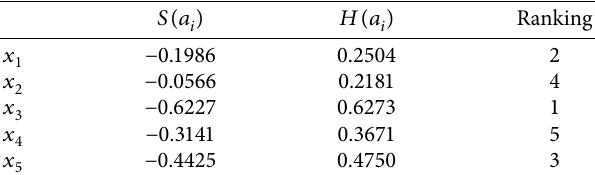
Table 5: Score and accuracy